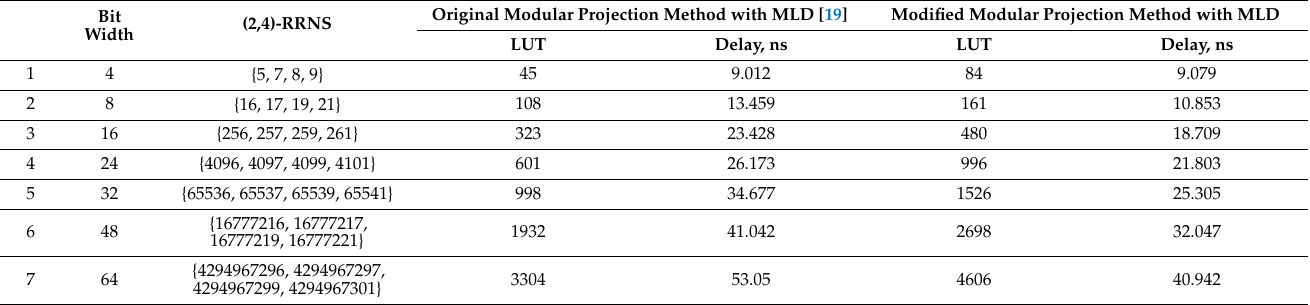
Table A7. Hardware and time costs for correcting single errors and restoring numbers in WNS.